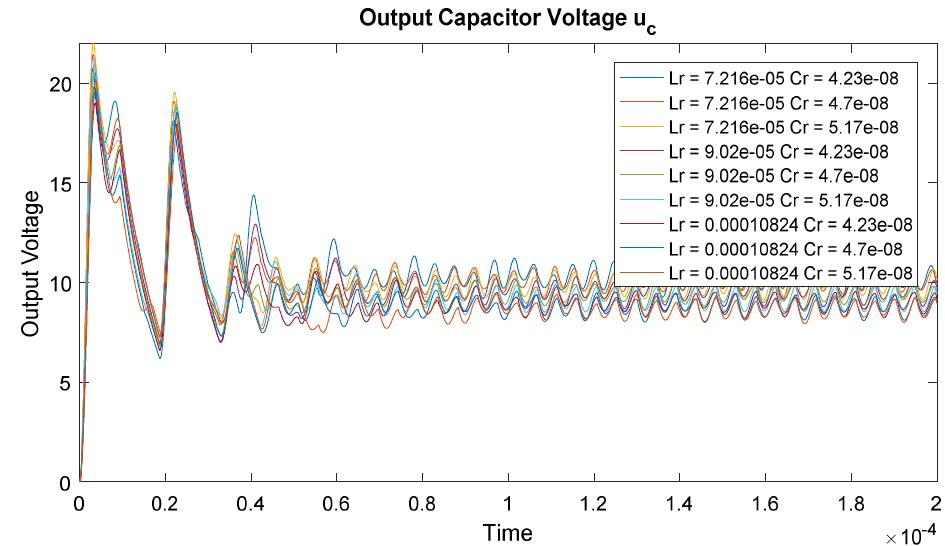
Figure 19. Tolerance analysis results with optimization, conducted with Simulink Response Optimization.